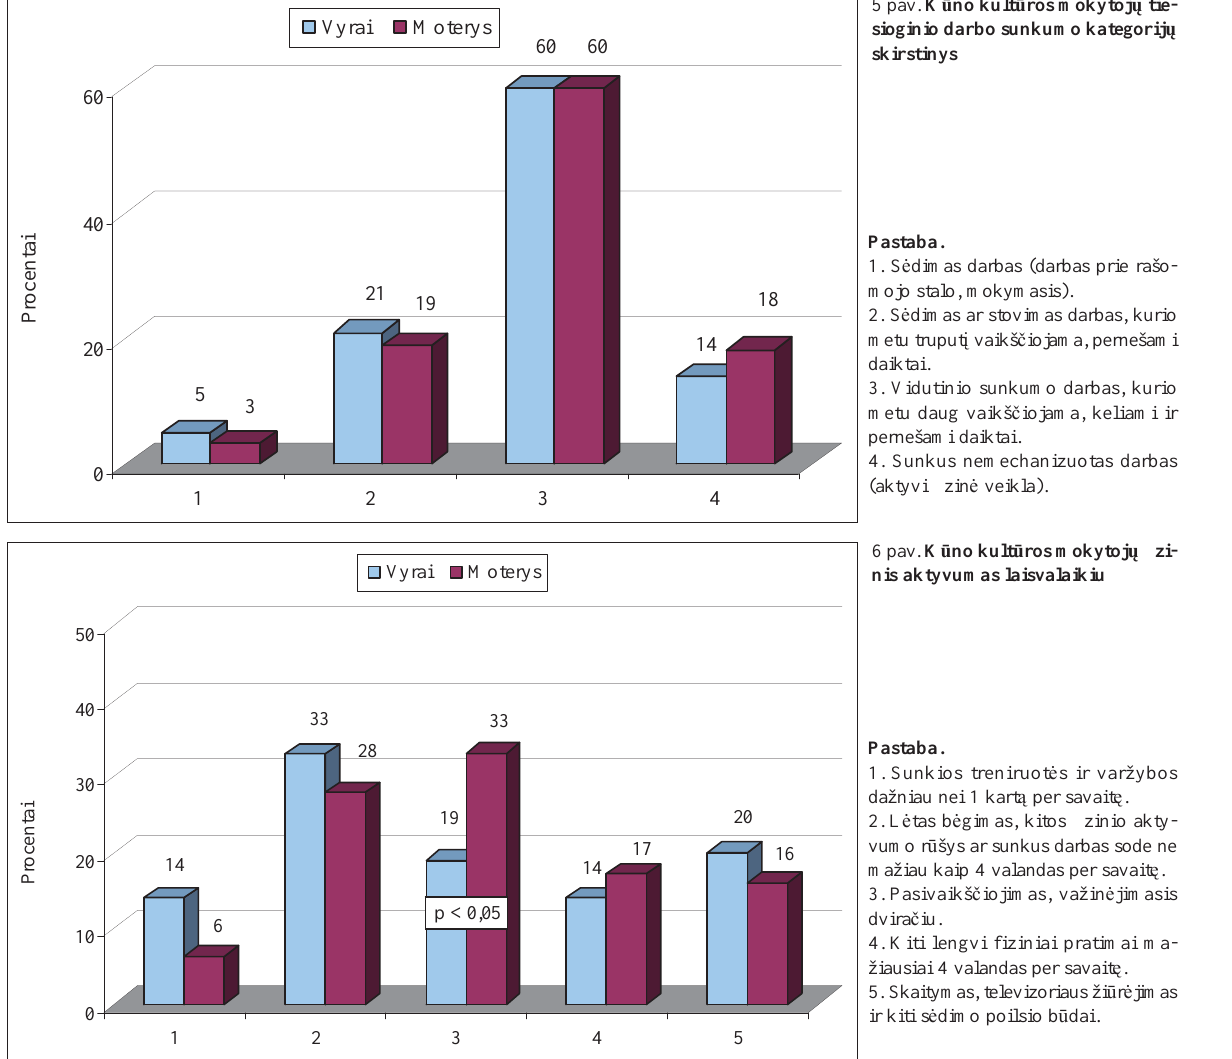
Virtas daržoves kasdien vartoja 2% k ū